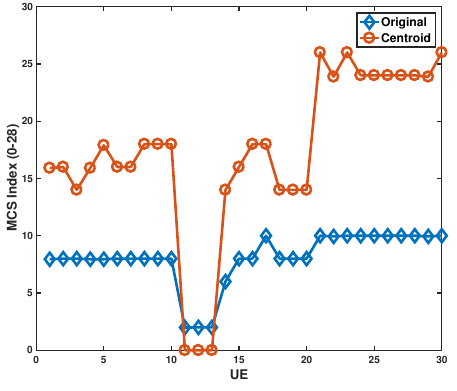
Figure 9. SINR Performance vs. Number of UEs Figure 10. MCS Index vs. Number